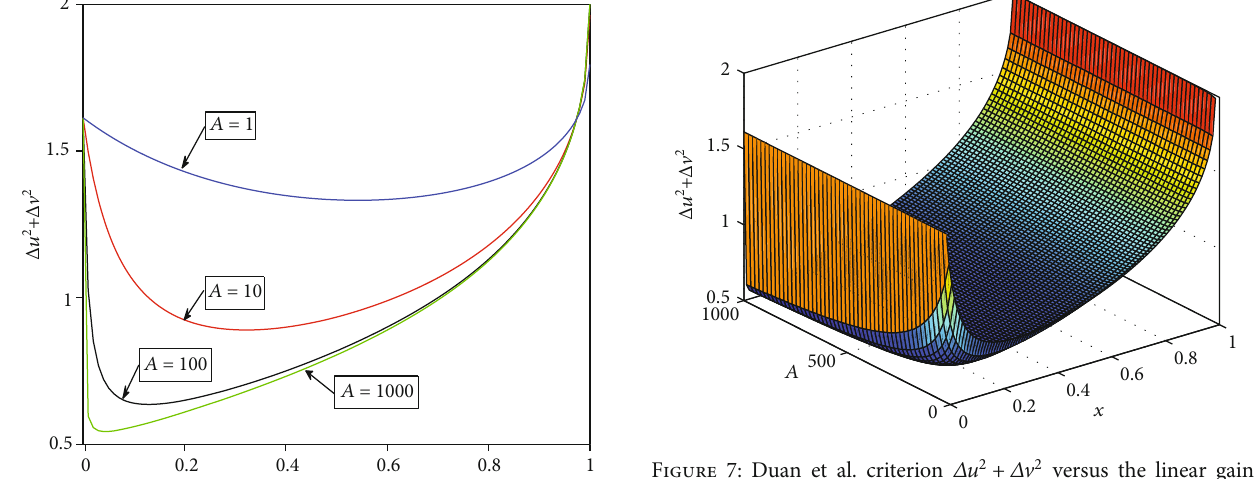
Figure 7: Duan et al. criterion Δ u 2 + Δ v 2 versus the linear gain coe ffi cient A and initial preparation of atoms x for κ = 0 : 5 and ε = 0 : 06